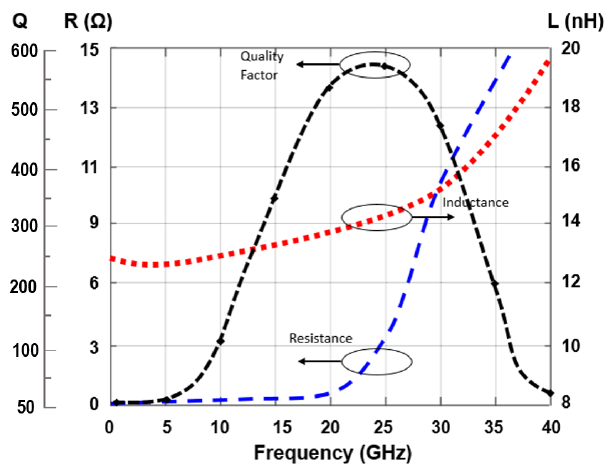
Figure 9. Quality factor of the designed TAI with varying bias voltage.